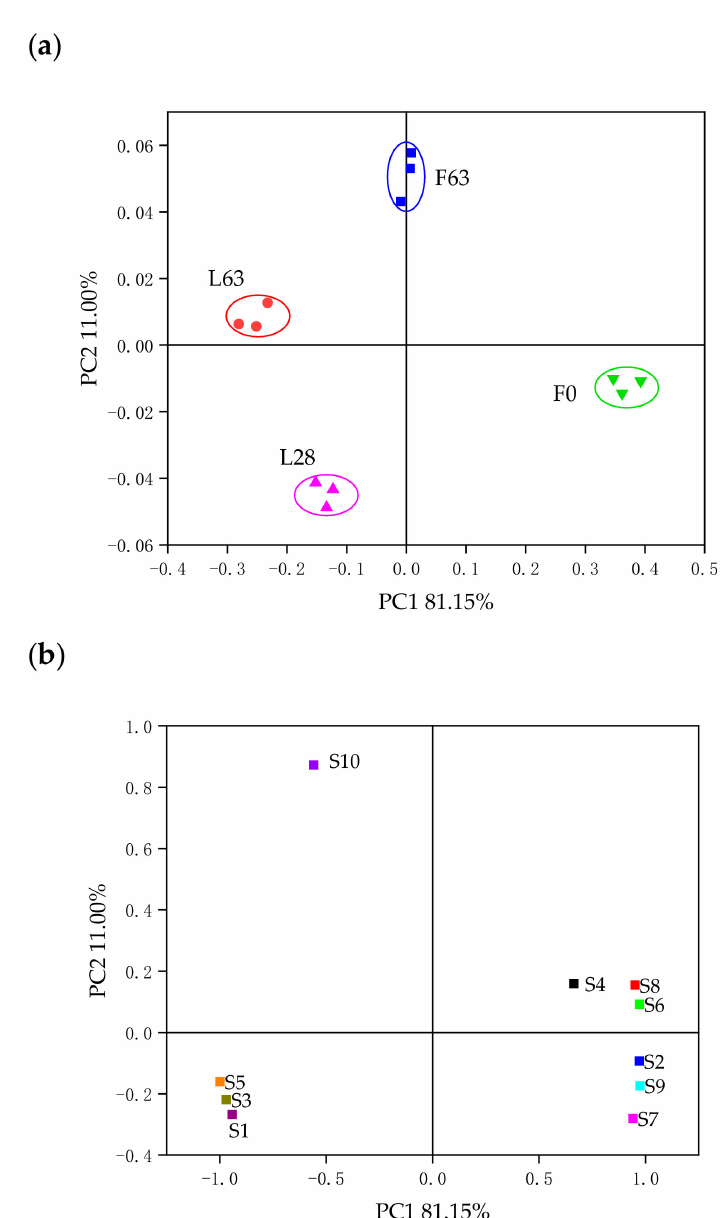
Figure 5. PCA results for E-nose analysis of different samples. Loading plot ( a ); score plot ( b